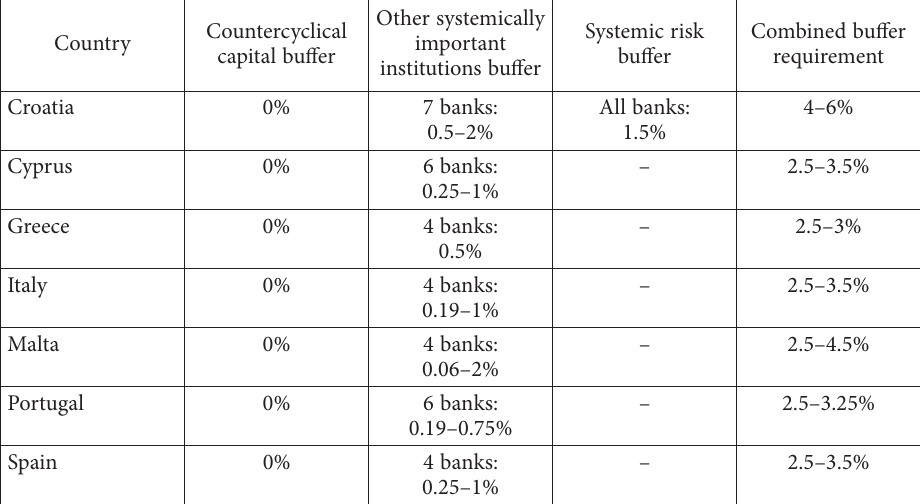
Table 3. Implemented macroprudential measures in selected EU (source: European Central Bank, 2021c and central banks of selected countries, 2021)